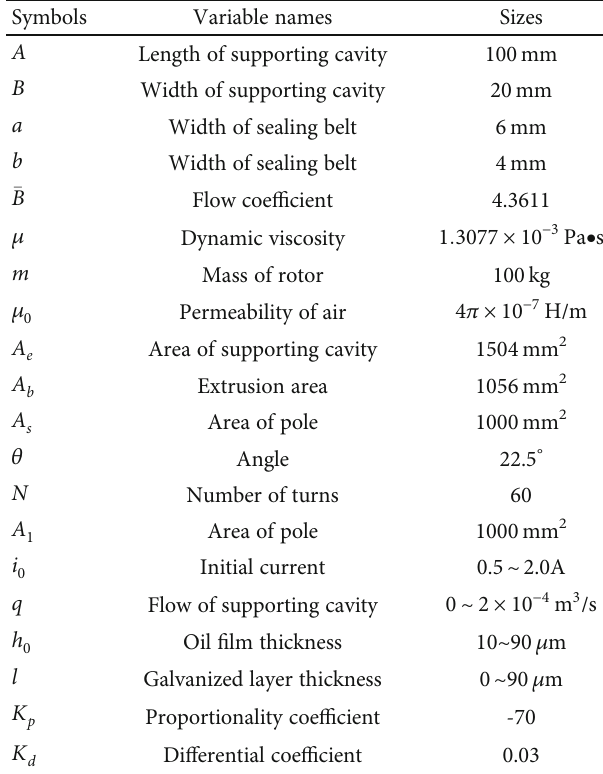
Figure 4: Single DOF support regulation principle of MLDSB. Table 1: Design parameters of